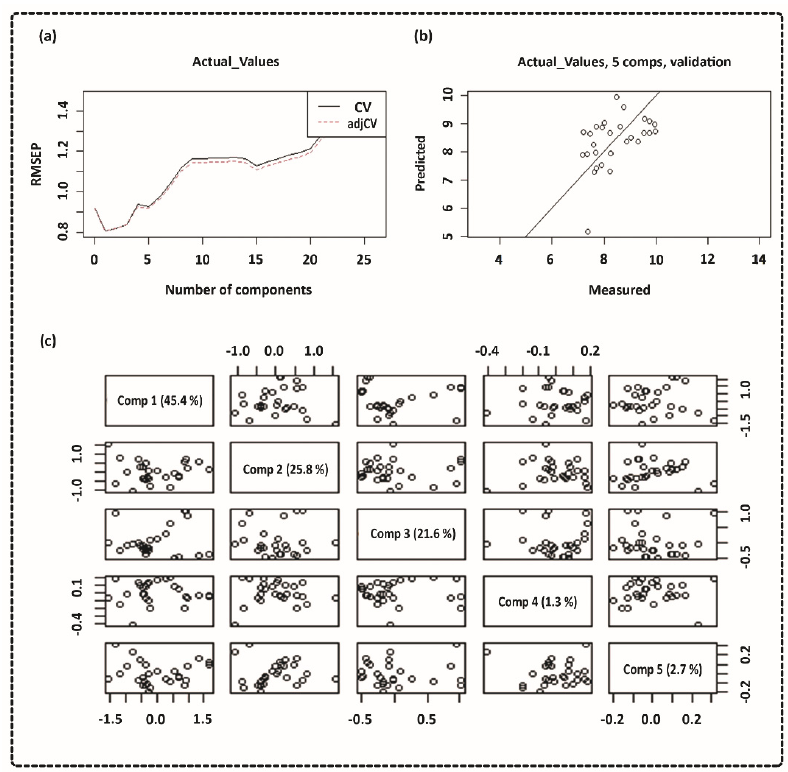
Figure 5. Partial-least-squares regression (PLSR) model using the 1000–2000 nm NIR range. ( a ) Cross-validation of root-mean-squared error of prediction (RMSEP) curves for pH data; ( b ) cross-validation prediction of pH data; ( c ) score plot of pH data.